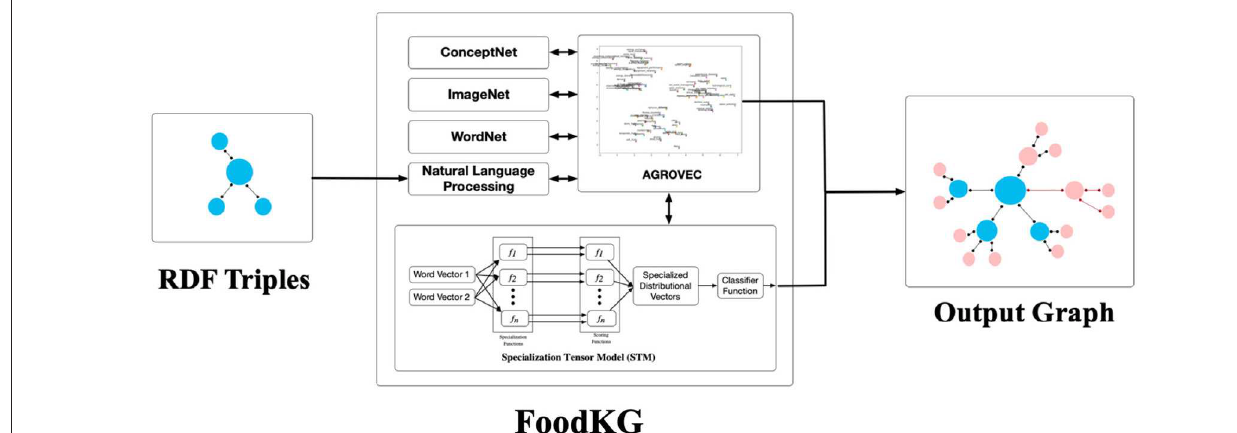
FIGURE 1 | FoodKG system architecture.